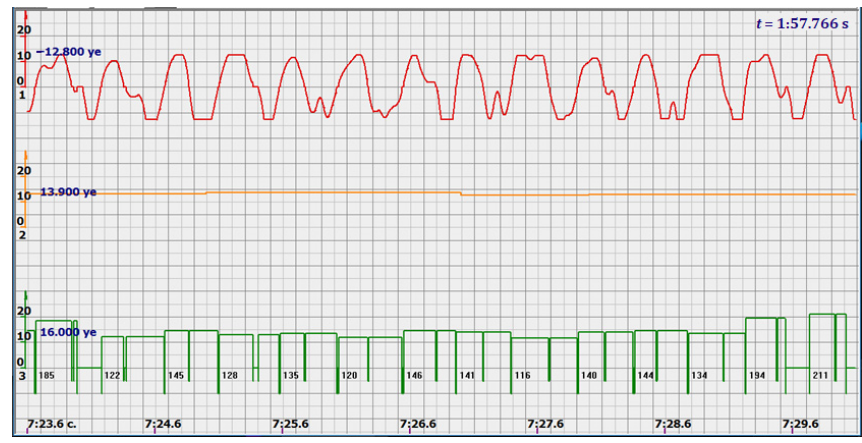
Figure 16. Heart rate—from 122 to 146 bpm.